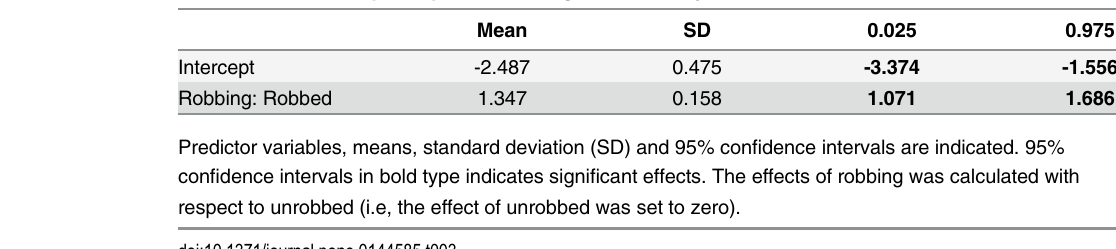
Table 3. Effect of striped-squirrels robbing on broken